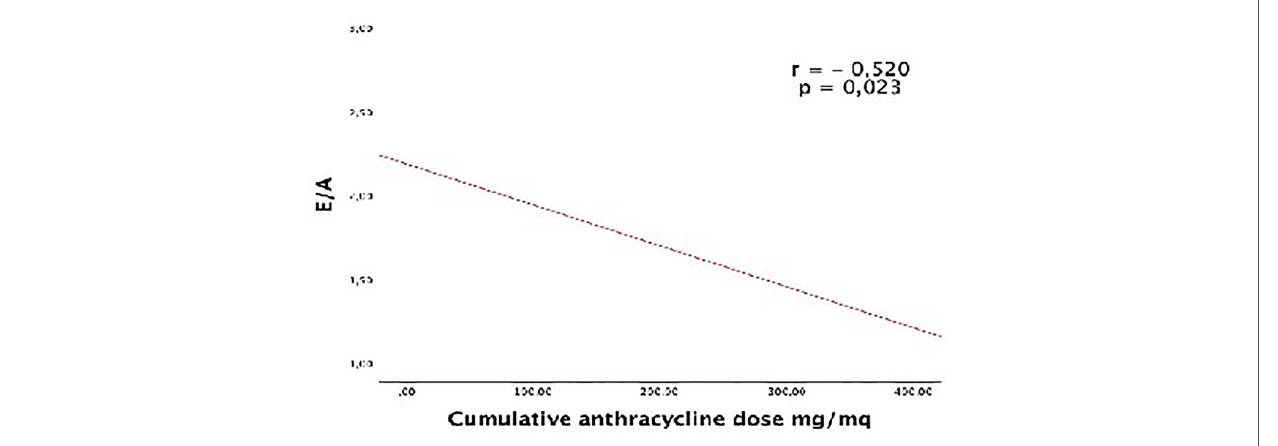
FIGURE 1 | Correlation between the E/A ratio and the cumulative anthrax cycline dose.